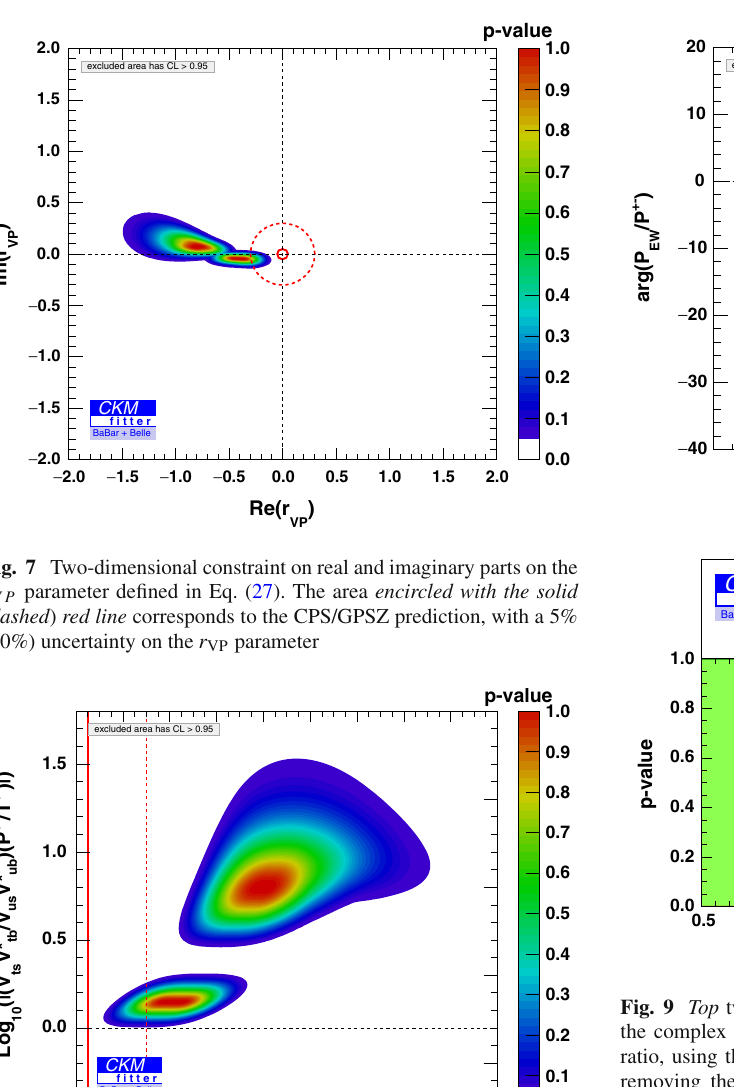
troweak penguins. Solutions I and II show the same structure with four different local